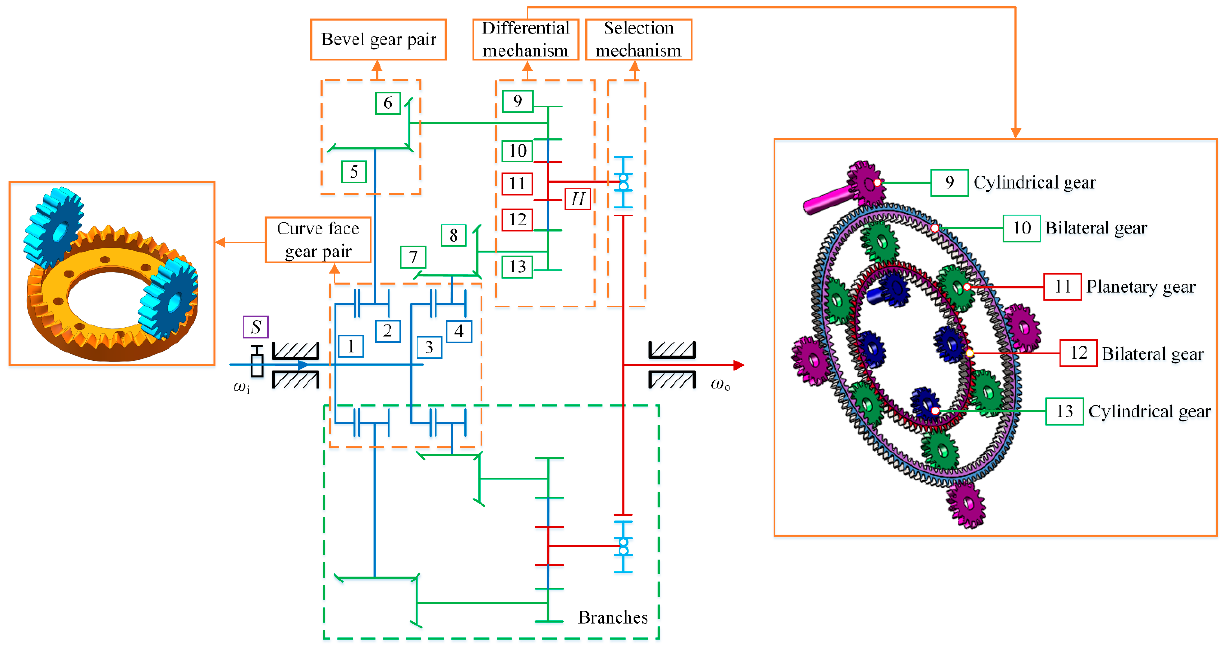
Figure 5. Transmission principle of class C.